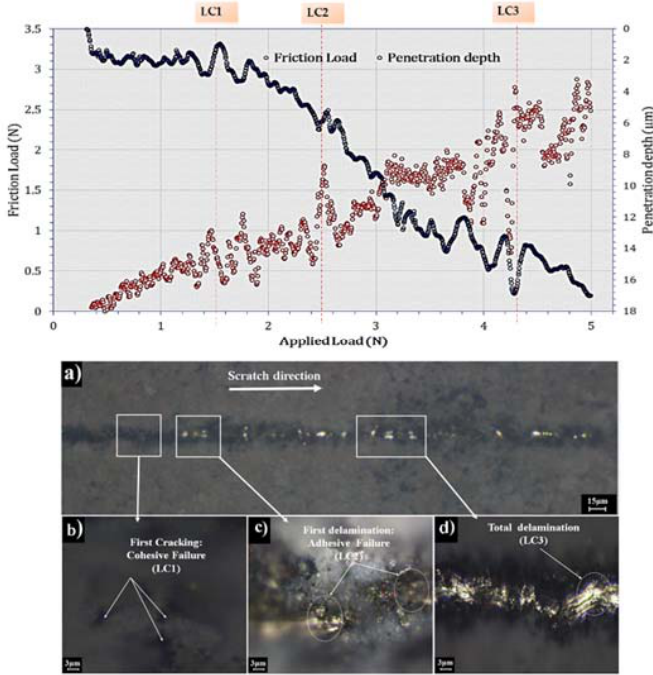
Figure 10. Variation in the friction load and penetration depth as a function of the applied load and the correspondonding optical micrographs of scratch tracks of the heat coated HAP coating: ( a ) scratch track; ( b ) first cracking; ( c ) first delamination; ( d ) total delamination.